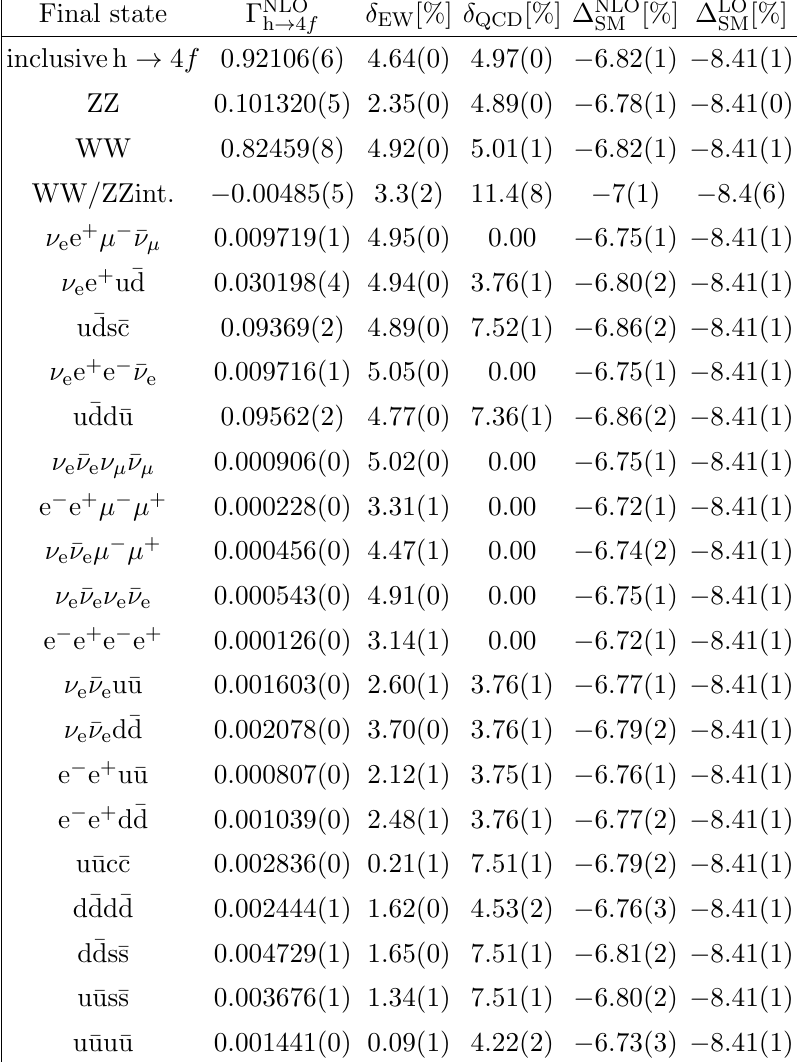
Table 3 . Partial widths for scenario BHM200 + in the FJ renormalization scheme. The integration errors are given in